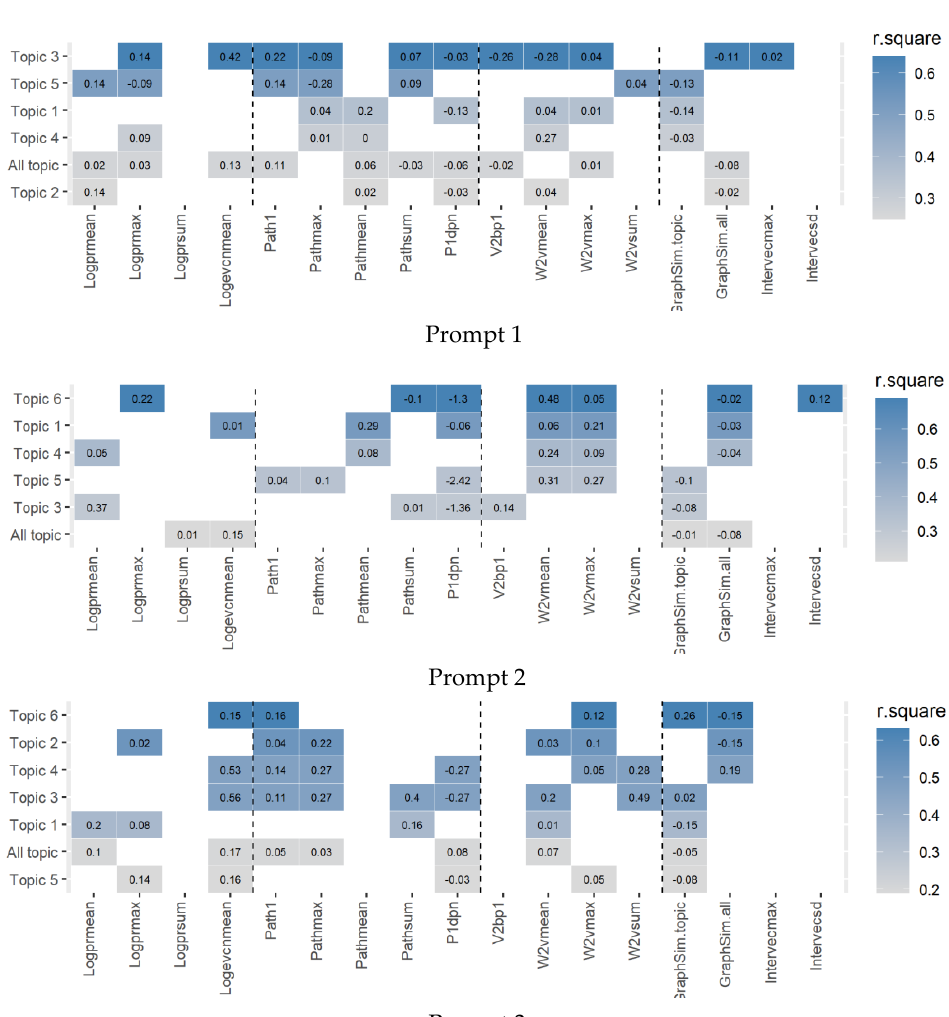
Figure 6. Heatmap of the R-square values of lasso. Colored cells display the selected features for predicting originality scores for each topic. The darker the cell, the higher the R-square in the prediction model. The three vertical dashed lines separating four types of features from left to right are centrality, path distance, semantic differences, and similarity. The “All topic” line of each panel is the result of task-level lasso analysis, which takes all essays under the given task for modeling; the other lines are the results of topic-level models using essays under the corresponding topic.